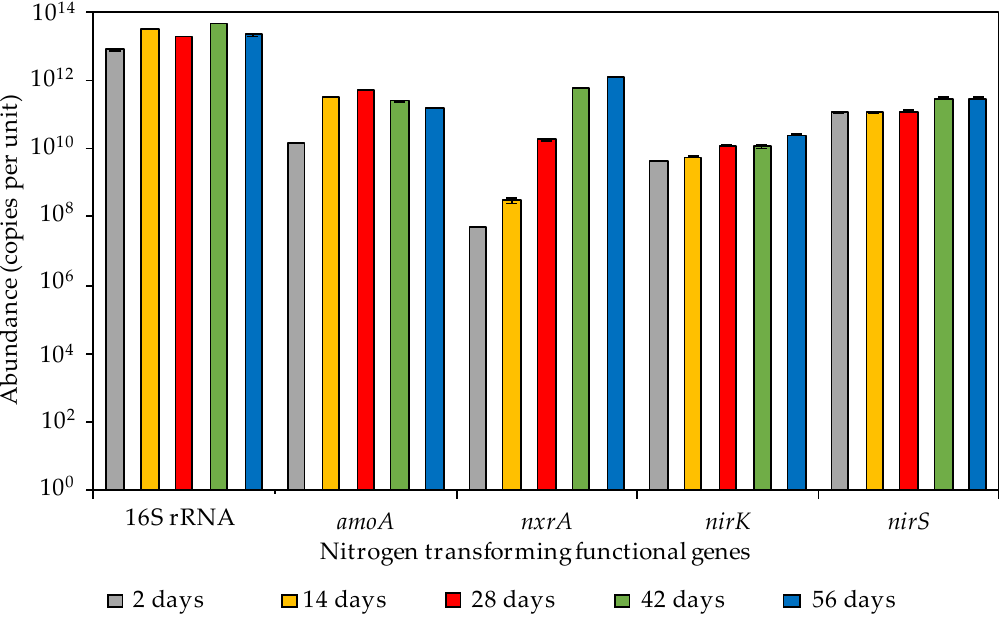
Figure 3. Changes in the abundances of 16S rRNA, amoA , nxrA , nirK , and nirS in the dropping nitrification units over 56 days of operation. Average numbers of gene copies ± SD are shown for duplicate experiments.